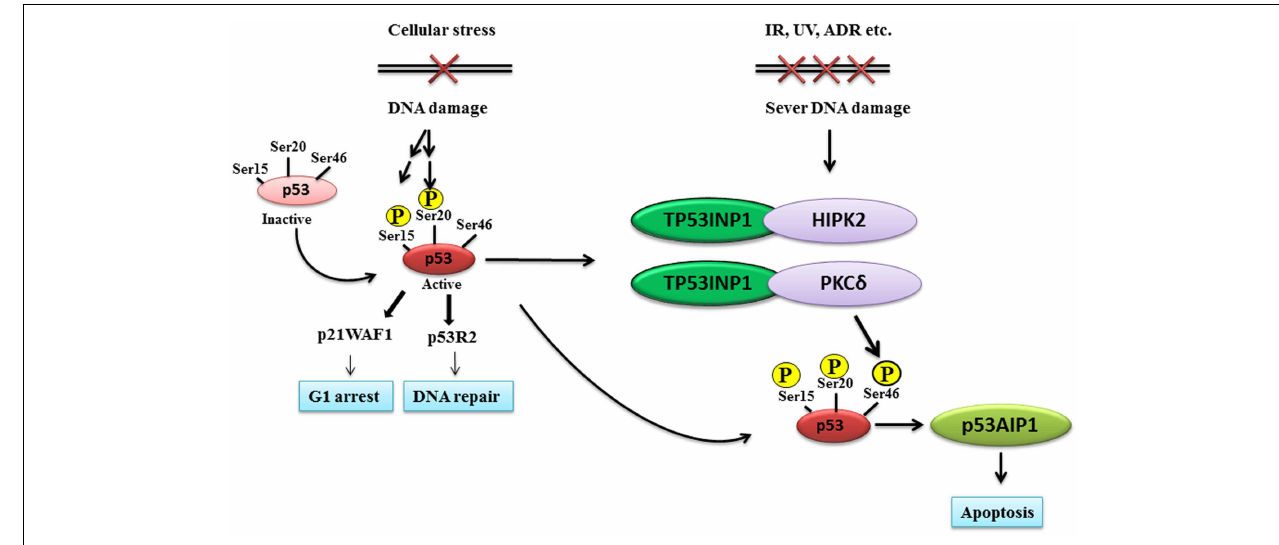
DNA repair gene p53R2 and p53 negative regulators. If DNA damage is severe,TP53INP1 forms protein complexes with the Ser-46 kinase HIPK2 and PKC δ , leading to p53 protein phosphorylation at Ser-46, induction of p53AIP1 gene transcription and